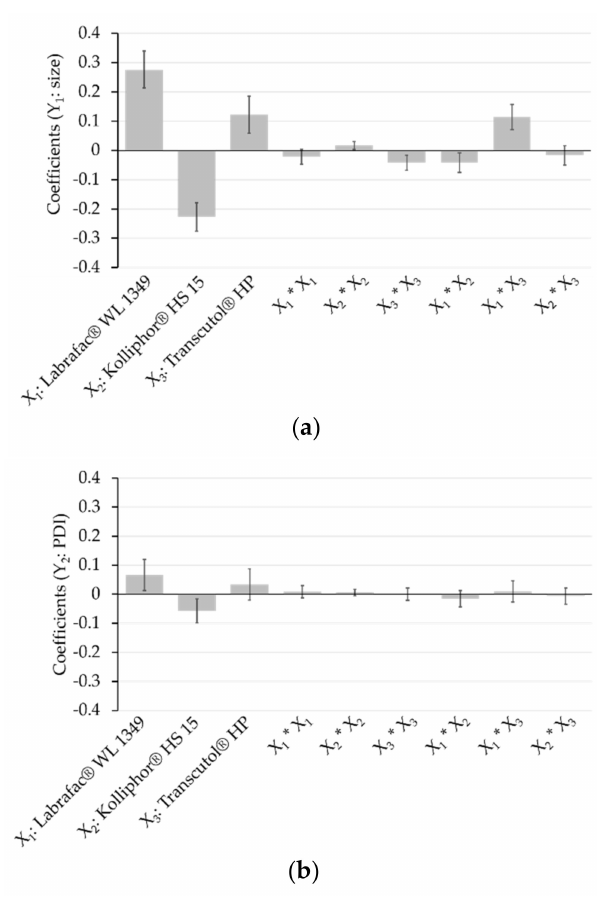
Figure 2. Plot of the regression coe ffi cients of the variables X for the responses Y 1 : size ( a ) and Y 2 : polydispersity index (PDI) ( b